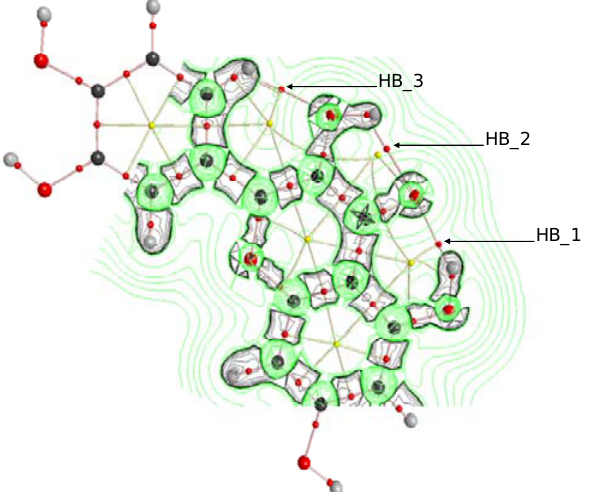
Figure 9. AIM analysis for flavonoid XIII (quercetin). Small red dots represent bond critical points, small yellow dots represent ring critical points, pink lines represent bond paths, yellow lines represent ring paths, large dots represent attractors (atoms; red, oxygen; black, carbon and gray, hydrogen). Contour plots represent laplacian of electron density,  2  , in the vicinity of HB_1 to HB_3 hydrogen bonds; green curves, positive isosurface values of  2  and black curves, negative isosurface values of  2  . Contour plot in the vicinity of possible HB_5 is not represented because AIM analysis does not reveal any bond critical point in that region, and thus no hydrogen bond should be present according to this